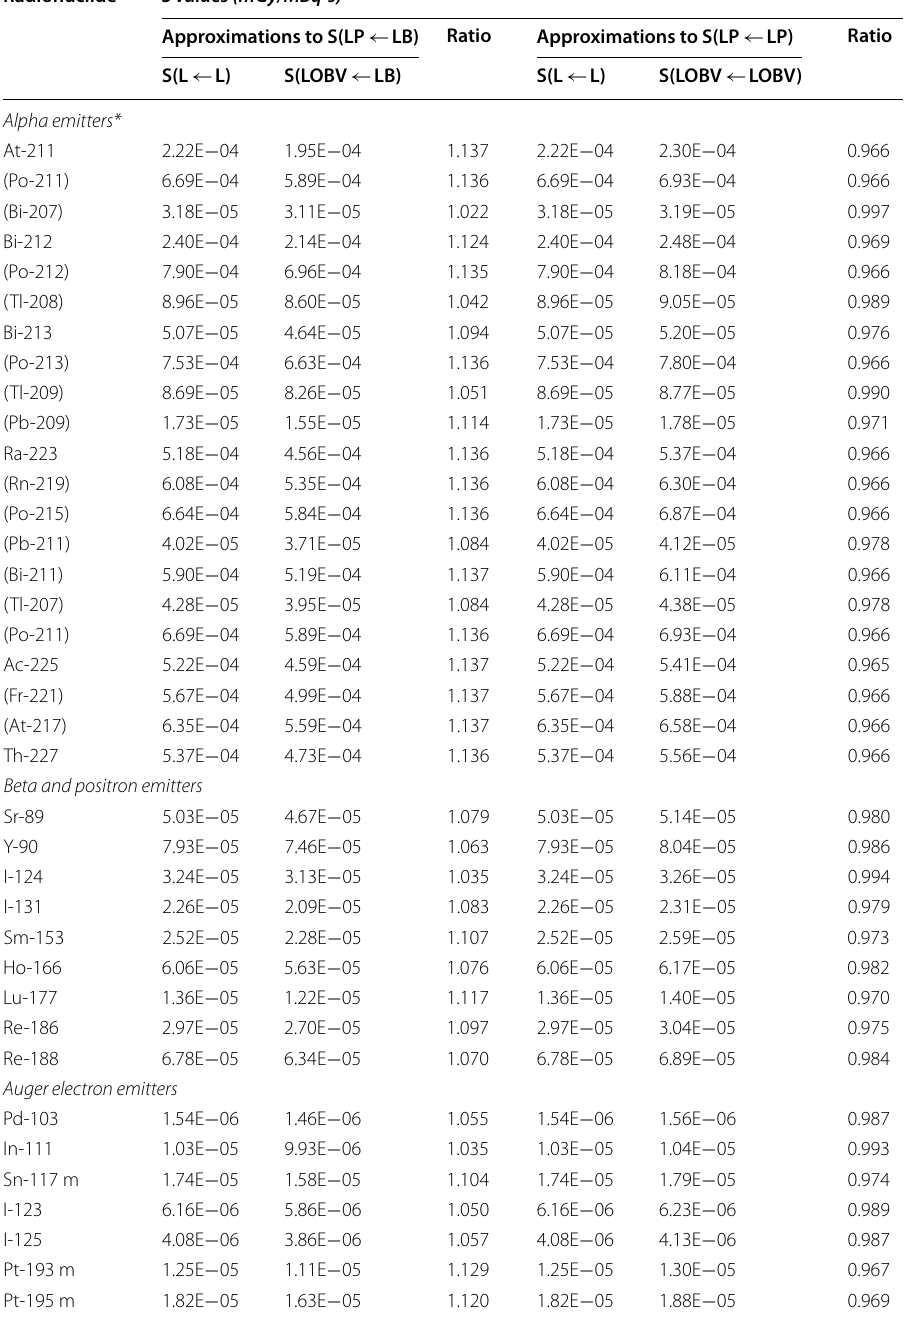
Table 4 Approximations of S ( LP ← LB ) and S ( LP ← LP ) values for 22 radionuclides (and 14 additional alpha‑emitter decay progeny) with applications to radiopharmaceutical therapy using the single‑ region and dual‑region tetrahedral mesh models of the reference adult female liver